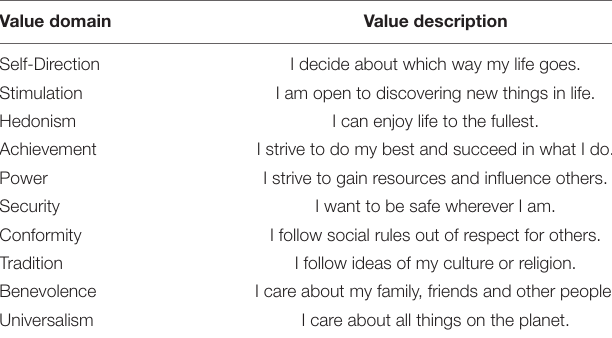
TABLE 1 | Example of a 10-fold item assessing the 10